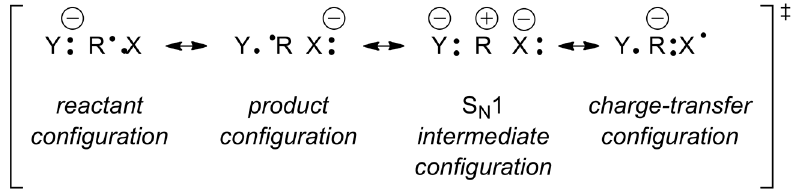
Figure 12. An S N 2 transition state model for the reactions of type c in Scheme 35.